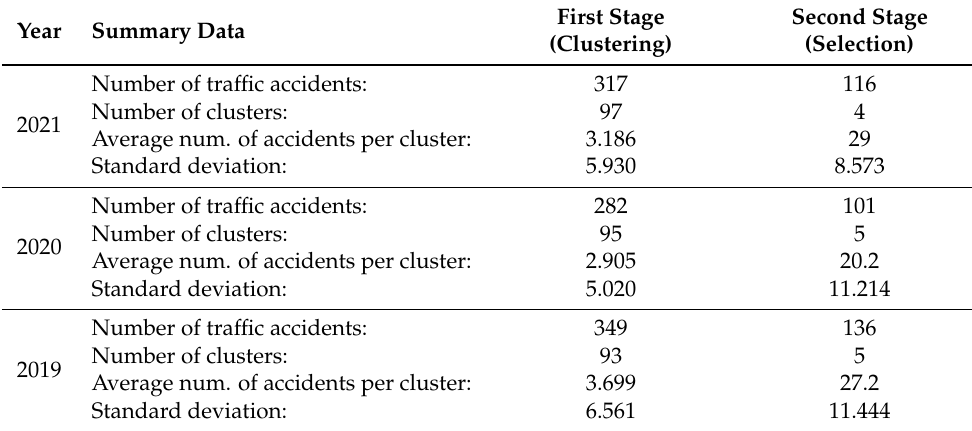
Table 3. A summary of the clustering and selection results obtained when the introduced algorithm was applied to publicly available data on traffic accidents with injuries or death that occurred in the municipality of Zvezdara during 2021, 2020, and 2019,